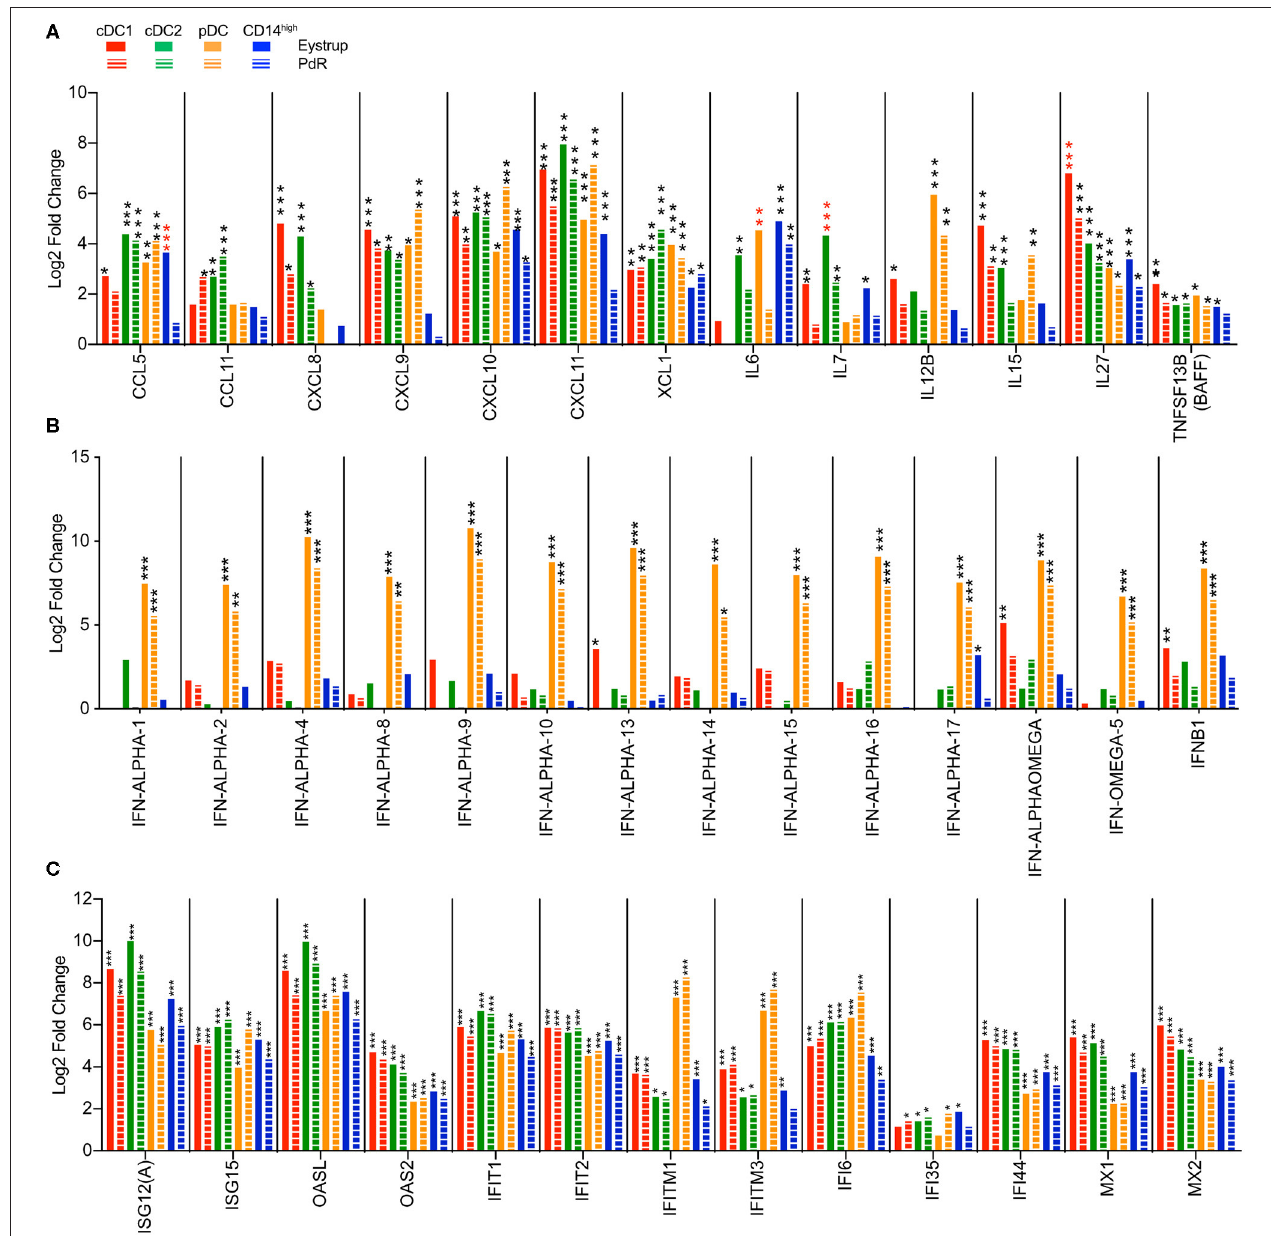
FIGURE 7 | Transcription profiles of LN mononuclear phagocytes after infection with the highly virulent (Eystrup) or the low virulent (PdR) strain of CSFV. cDC1, cDC2, pDC, and CD14 high populations were isolated from mandibular and retropharyngeal LN of animals infected with either Eystrup, PdR or left uninfected at 42h p.i. and their transcriptome was sequenced by RNA-Seq. Expression is displayed as log2-fold change between Eystrup-infected (solid columns) or PdR-infected (dashed columns) and control animals. (A) Significantly modulated expression of chemokine and cytokine genes. (B) Significantly modulated expression of type I IFN genes. (C) Expression of selected interferon-stimulated genes. DESeq2 analysis * padj < 0.05, ** padj < 0.001, *** padj < 0.0001. red-colored asterisks indicate statistical significance (padj < 0.05) between Eystrup- and PdR-infected animals for the same